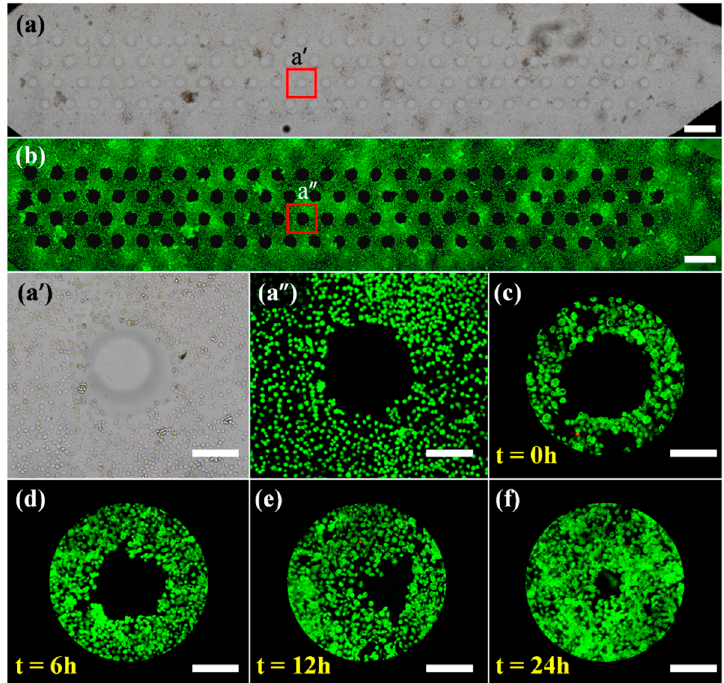
Figure 3. Scan images of ( a ) bright field and ( b ) fluorescence illustrate 100 CFZs in one of four cham- bers. Scale bar, 1 mm. ( a’ ) Bright-field and ( a ″ ) fluorescent micrographs are partial enlargements of the same red spot in ( a , b ), which shows that areas made in our device had almost no dead cells. ( c – f ) Time-lapse fluorescent images of cell migration in the microfluidic channel. Scale bar, 200 μ m.